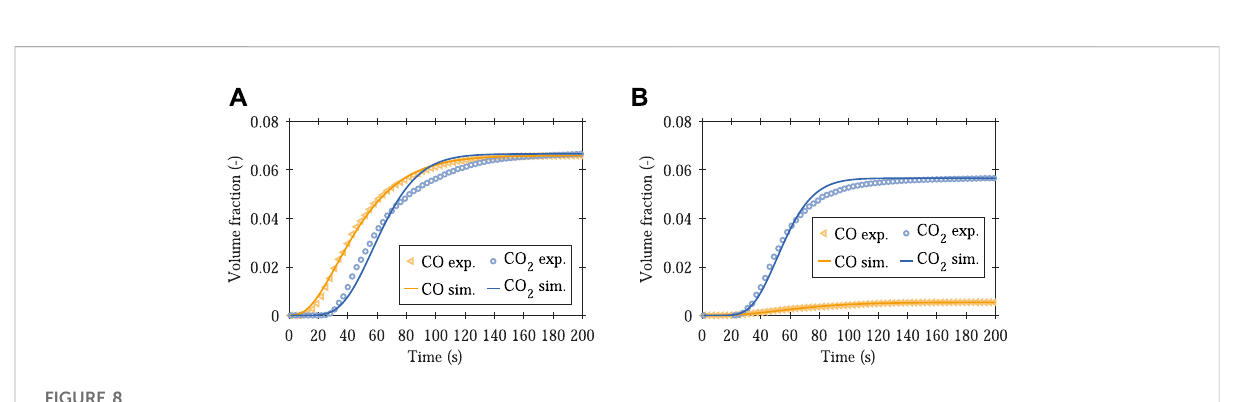
FIGURE 8 Exemplaryexperimentalandsimulatedbreakthroughcurves. (A) thirdcycleonpureK-HDMOsorbent(seeFigure6), (B) thirdcycleonK-HDMO sorbent and Cu/ZnO/Al 2 O 3 catalyst (see Figure 7).